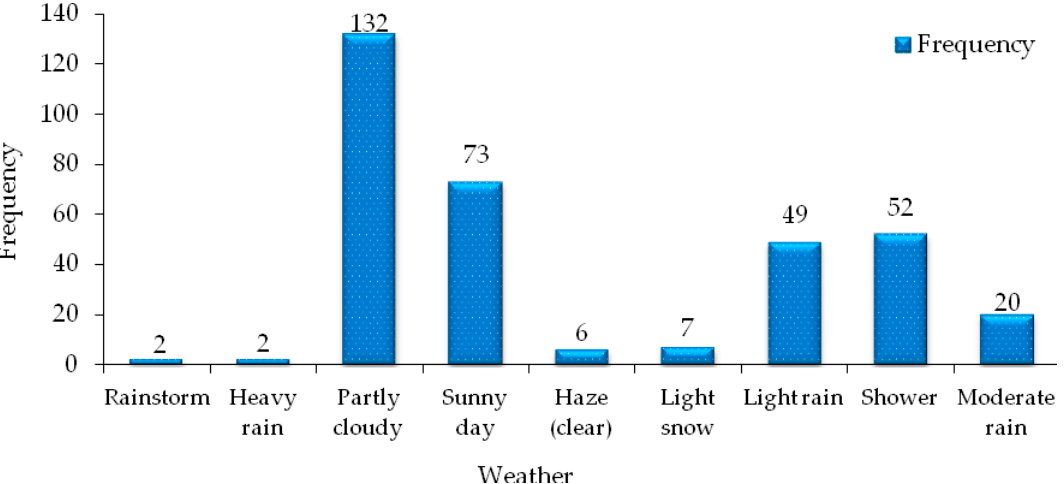
Figure 8. Weather distribution characteristics of hazardous materials transportation accident.